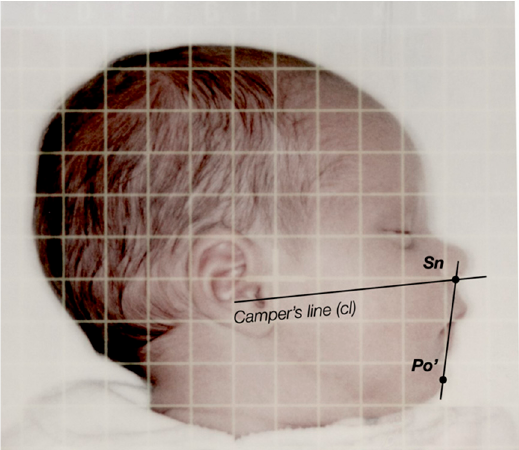
Figure 2. Examination of the infants’ profile, according to Camper’s line (cl). Camper’s line in infants is determined by a line running from the lower edge of the tragus of the ear to the inferior border of the ala of the nose. The lip shield covers the upper lip and lower lip of the child. These have different thicknesses depending on age, but orientation is based on the anthropometric landmarks Subnasale (Sn) and Pogonion molle (Po’).